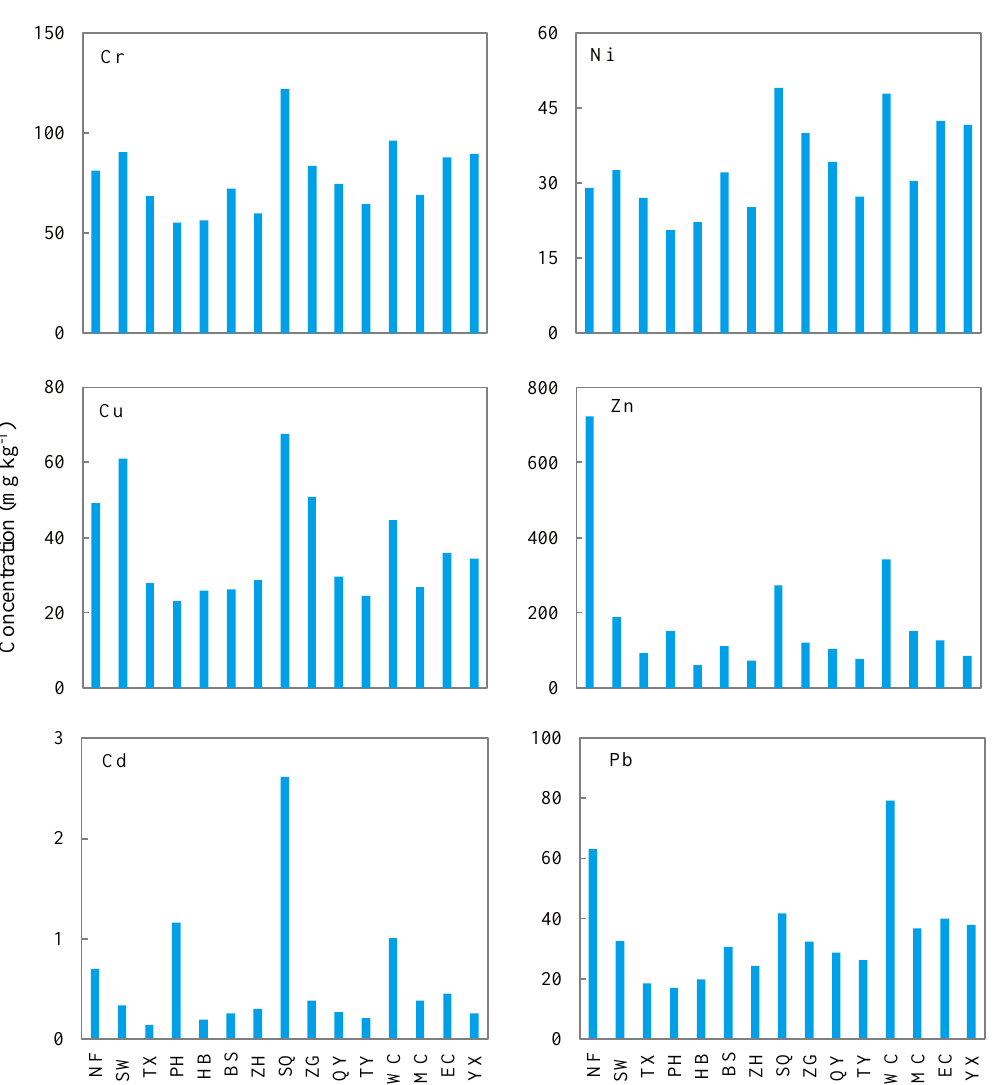
Figure 2. Cr, Ni, Cu, Zn, Cd, and Pb concentrations in sediments from 15 sampling sites. Specifically, there are 11 samples (NF, SW, TX, PH, HB, BS, ZH, SQ, ZG, QY, and TY) corresponding to 11 rivers flowing into Lake Chaohu, 3 samples (WC, MC, and EC) from Chaohu, and 1 sample (YX) from the river flowing out of